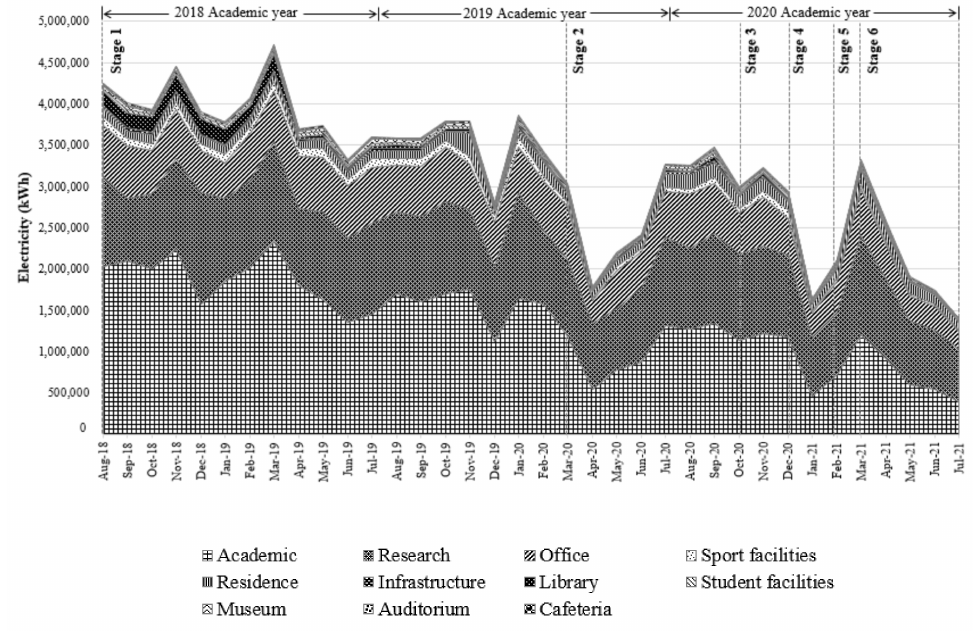
Figure 3. Pattern of electricity consumption (kWh) during AY2018 to AY2020 and the learning modes implications, plotting based on building function types.